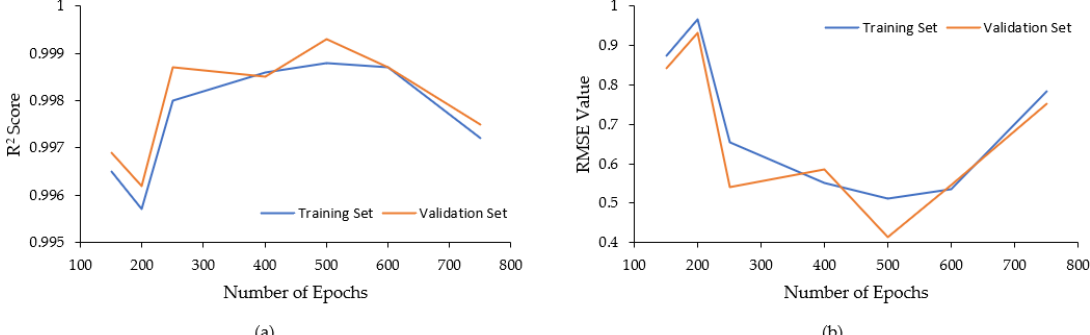
Figure 5. MLP regression model performance metrics for training and validation subsets, including ( a ) coefficients of determination (R 2 ) and ( b ) root mean-square-error (RMSE) values. Note the reversal in improvement at 500 epochs for both metrics.